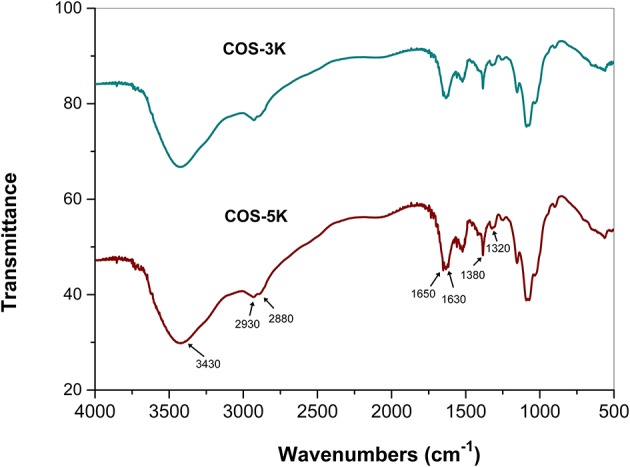
FTIR spectra of two COS.